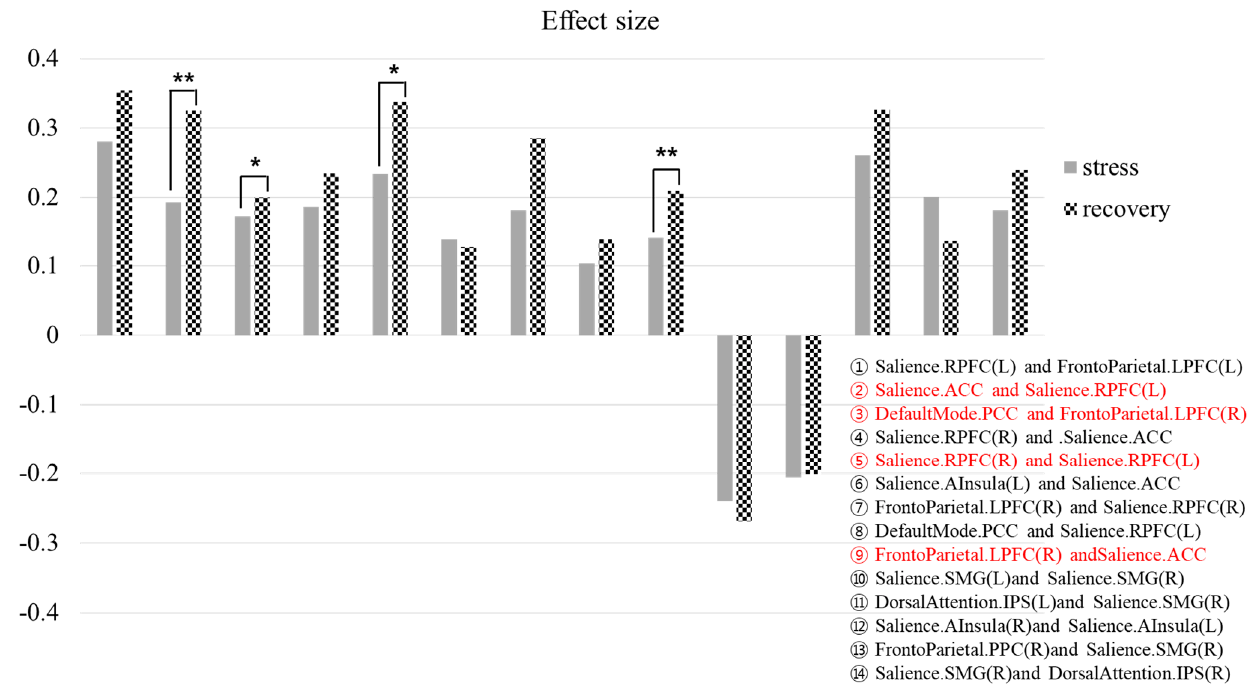
Figure 3. Comparison of the effect sizes of common functional connectivity in the stress phase and recovery phases. Red color : FC with statistically significant difference (** p < 0.01, * p < 0.05). FCs that were speci fi cally observed in the stress phase included the DMN (PCC) and SN (ACC), DAN (IPS, L) and DAN (IPS, R), and SN (SMG, L) and FPN (PCC, R). In the recovery phase, connectivity between the SN (ACC) and FPN (LPFC, L), SN (A Insula, R) and SN (ACC)/RPFC, L), SN (A Insula, L) and SN (RPFC, L), and SN (RPFC, R)